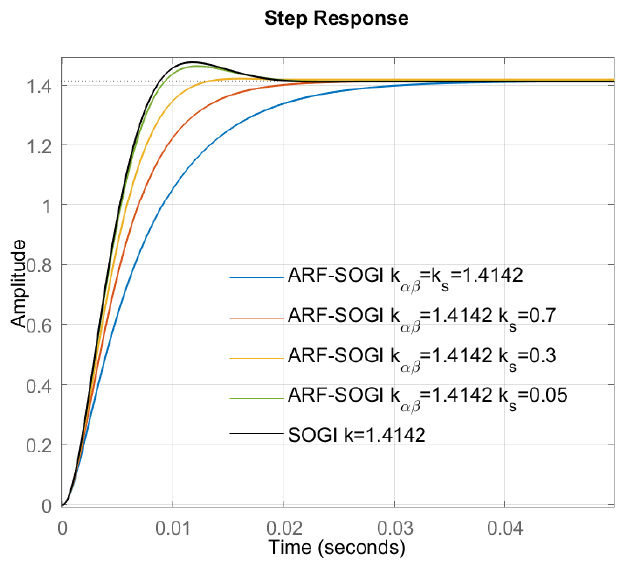
Figure 10. qv (cid:48) low-pass filter-step response of the SOGI-QSG